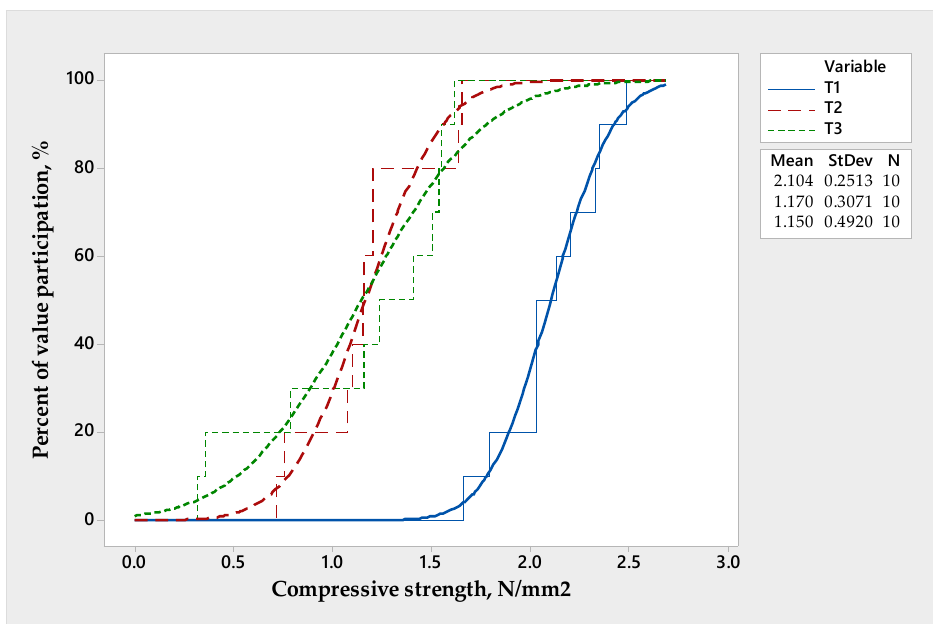
Figure 3. Empirical Cumulative Distribution Function (CDF) for compressive strength of straw briquettes.